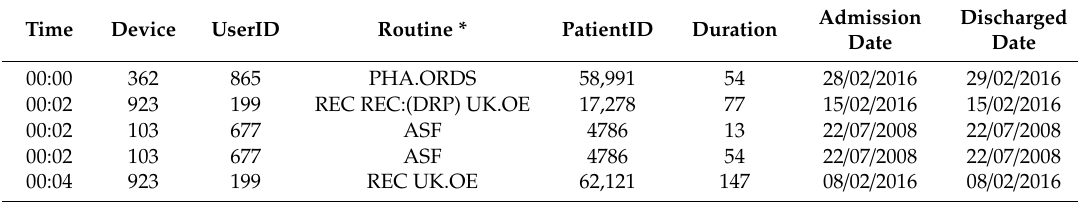
Table 3. Routine